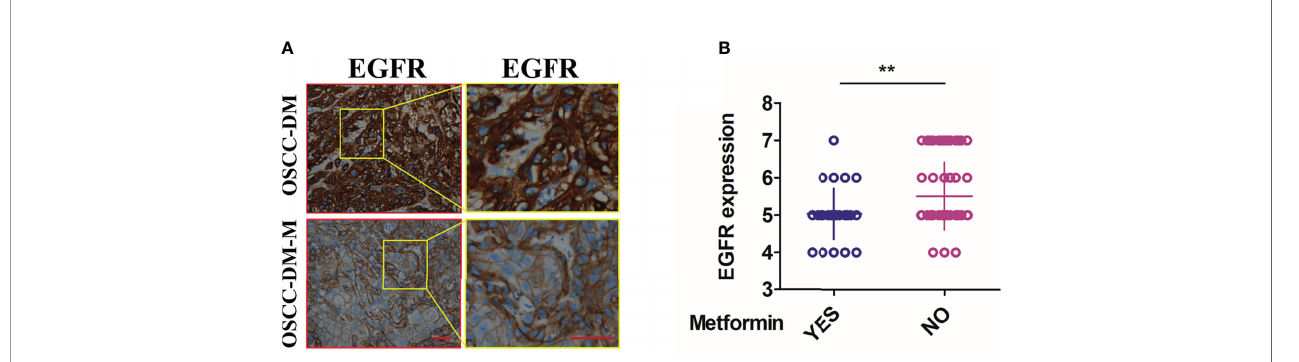
FIGURE 1 | Expression of EGFR in the cancer tissues of OSCC-DM-M group and OSCC-DM group. (A) typical pictures of EGFR staining in the OSCC-DM-M and OSCC-DM group. (B) Semi-quantitative analysis results in the OSCC-DM-M and OSCC-DM group. Scale bar, 200 m m, ** P